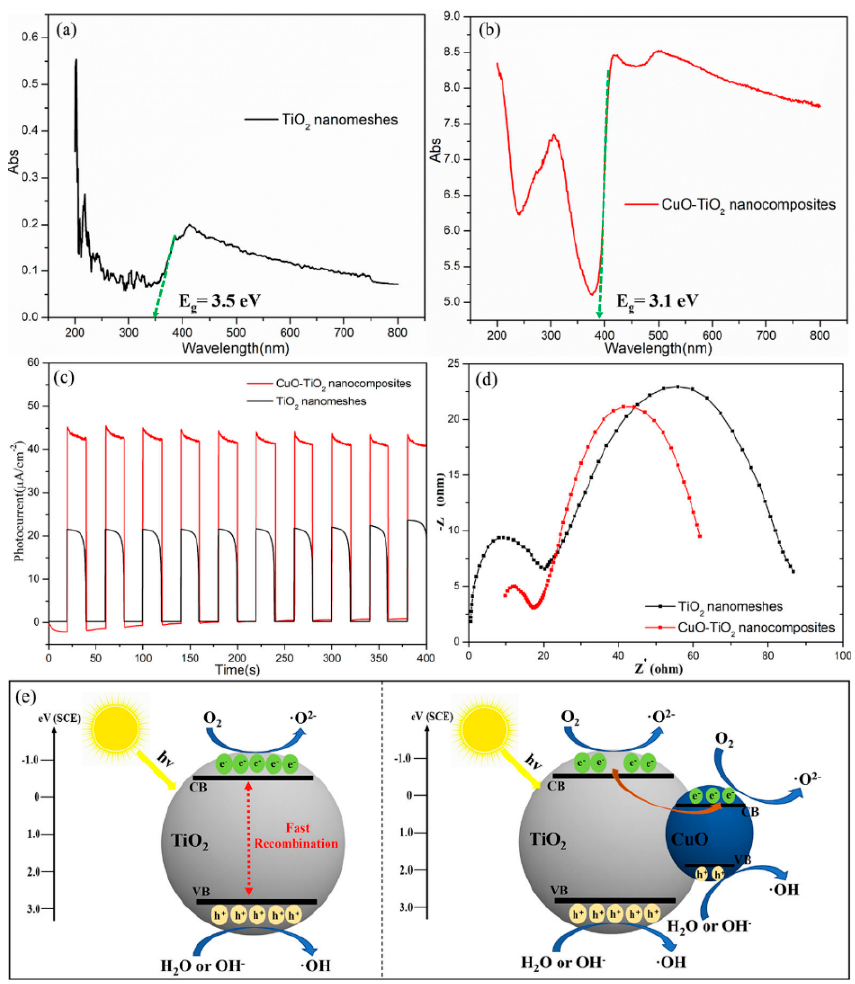
Figure 5. ( a , b ) UV–vis DRS absorption curves of TiO 2 nanomeshes and CuO-TiO 2 nanocomposites; ( c ) photocurrent-time image of CuO-TiO 2 nanocomposites and TiO 2 nanomeshes; ( d ) Nyquist plots of CuO-TiO 2 nanocomposites and TiO 2 nanomeshes; ( e ) possible photocatalytic mechanism of CuO- TiO 2 nanocomposites.